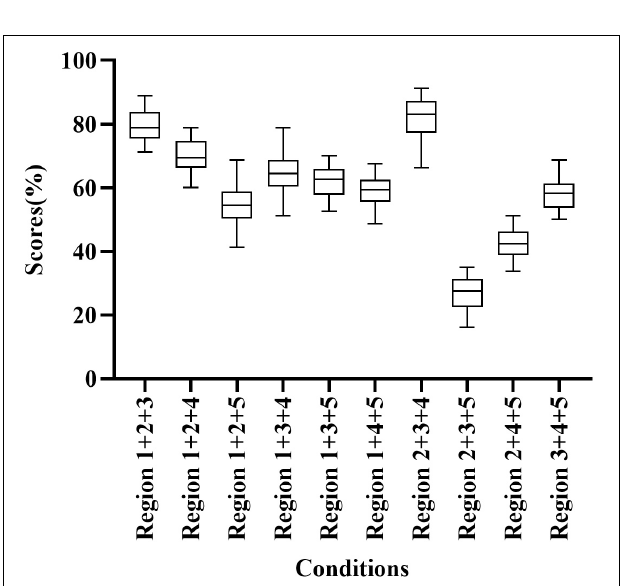
FIGURE 2 | Percent-correct scores for disyllabic word recognition using acoustic temporal envelope in three-frequency-region